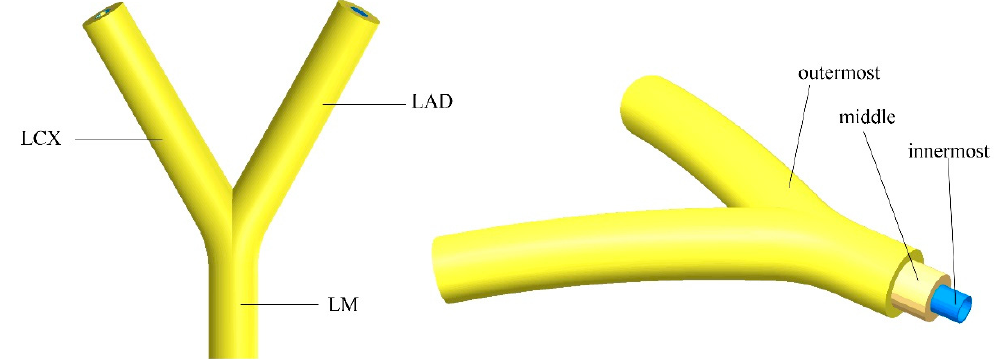
Figure 1. The geometry model of the proposed tissue engineered vascular grafts (TEVGs) based on left coronary artery. LCX–left circumflex; LAD–left anterior descending; LM–left main artery. Table 1. Dimensions of the inner channel of the tissue engineered vascular grafts (TEVGs). Vessel